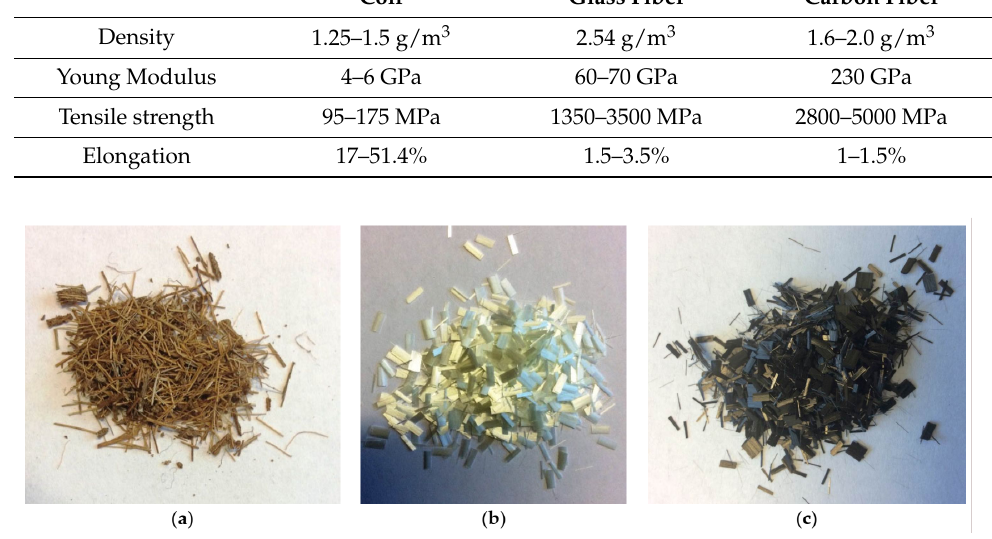
Figure 1. Short fibers ( a ) coir (after crushed), ( b ) glass fiber, and ( c ) carbon